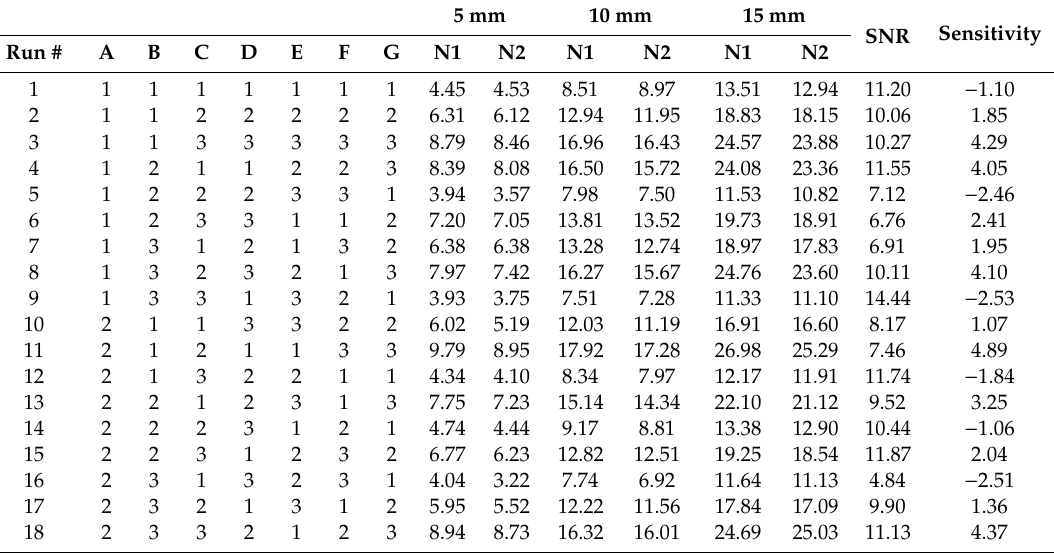
Table 2. L 18 experimental result of signal-to-noise ratio (SNR) and sensitivity β